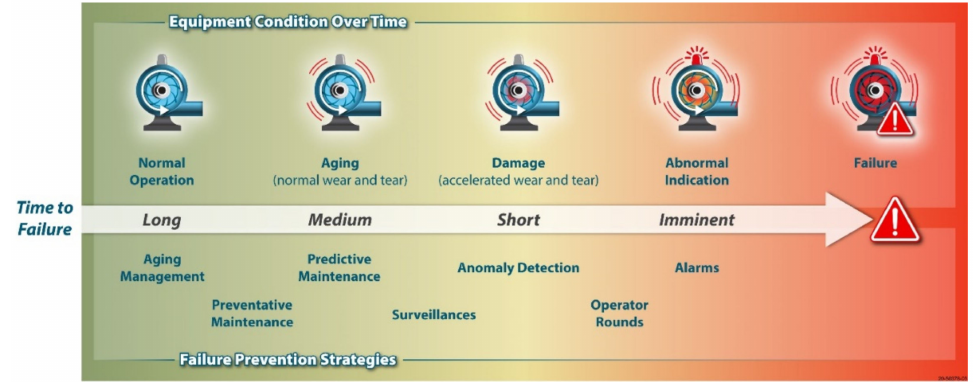
Figure 1. The layers of defense in prediction and prevention of equipment